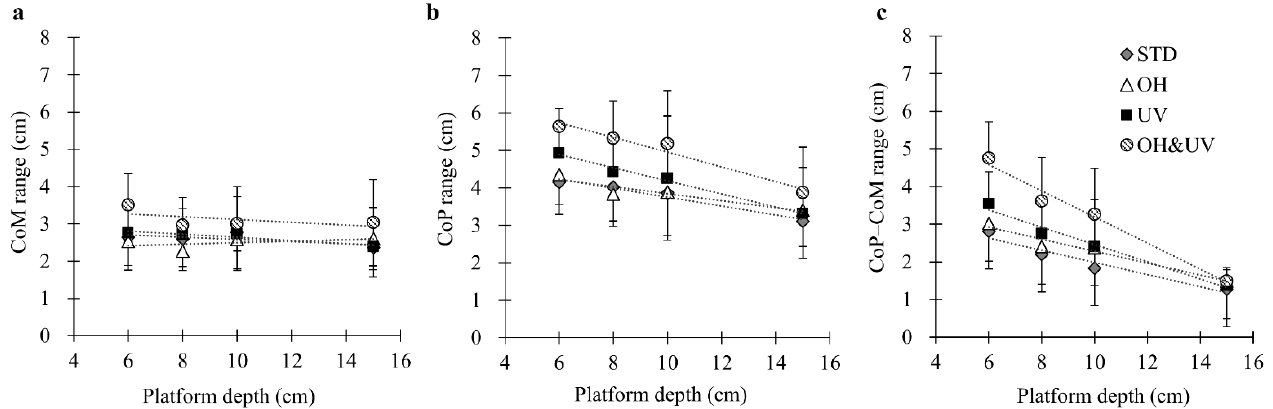
Figure 4. Absolute maximum ranges in the sagittal plane: ( a ) center of mass (CoM), ( b ) center of pressure (CoP), and ( c ) CoP–CoM displacement. Dotted lines show the linear approximate curves for the platform depth ( y = a * d + b ). For coefficients of the fitting functions and the significance test of the regression model, see Appendix A.